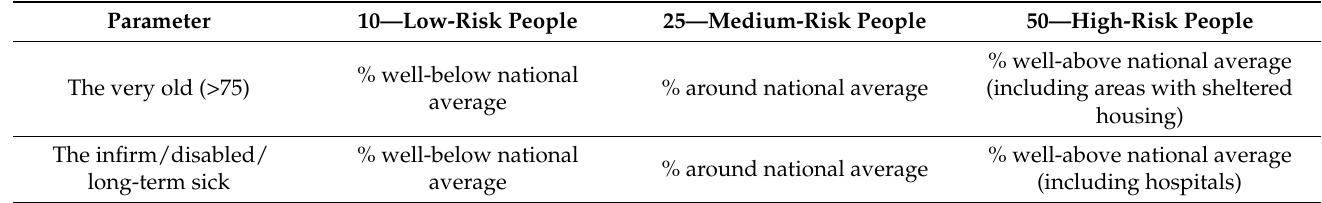
Table 5. Vulnerability of people [31].